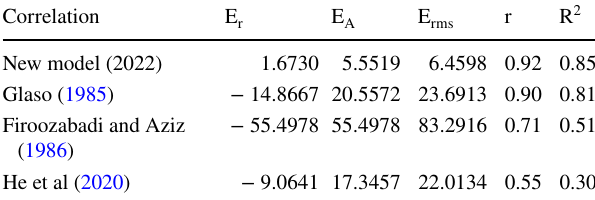
Fig. 6 Cross-plot of MMP training data for He (2020) correlation Table 5 Statistical analysis for predicted MMP (testing set) Correlation